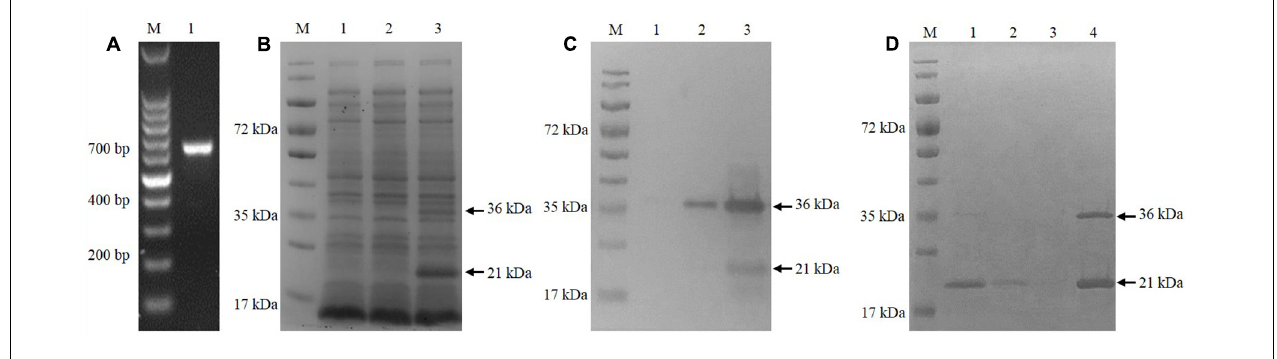
FIGURE 1 | Expression of recombinant MEDLE-2 protein in Escherichia coli . (A) PCR amplification of the cgd5_4590 gene in C. parvum . Lane M: 100-bp molecular makers; Lanes 1: cgd5_4590 PCR product. (B) Expression of recombinant MEDLE-2 protein in E. coli BL21 (DE3) revealed by SDS–PAGE analysis. Lane M: protein size makers; Lane 1: lysate from bacterial cells transformed with pET28a vector control; Lane 2: lysate from bacterial cells transformed with pET28a-cgd5_4590 without IPTG induction; Lane 3: lysate from bacterial cells transformed with pET28a-cgd5_4590 with IPTG induction. (C) Expression of recombinant MEDLE-2 protein in E. coli BL21 (DE3) revealed by Western blot analysis using Anti-His tag. Lane M: protein size makers; Lane 1: lysate from bacterial cells transformed with pET28a vector control; Lane 2: lysate from bacterial cells transformed with pET28a-cgd5_4590 without IPTG induction; Lane 3: lysate from bacterial cells transformed with pET28a-cgd5_4590 with IPTG induction. (D) Purity of recombinant MEDLE-2 revealed by SDS–PAGE analysis. Lane M: protein size makers; Lane 1: the first volume of washing solution with 20 mM imidazole from the purification column; Lane 2: the fifth volume of washing solution with 20 mM imidazole from the purification column; Lane 3: the eighth volume of washing solution with 20 mM imidazole from the purification column; Lane 4: target protein eluted from the purification column using 250 mM imidazole.